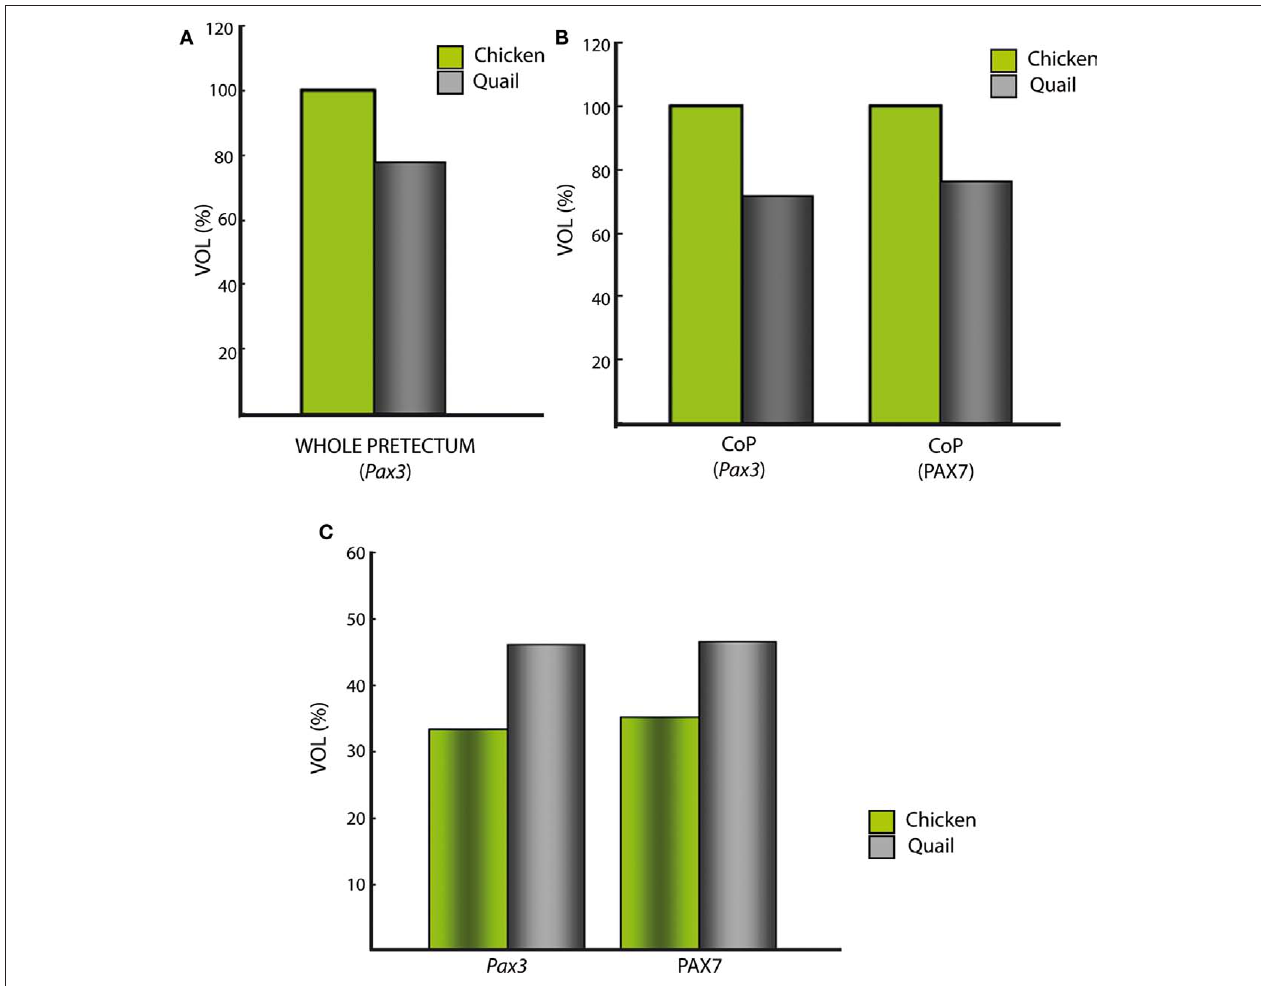
of the genes Pax3 and PAX7. The CoP volume of the chicken was standardized as 100%. Both calculations using Pax3 or PAX7 suggest a similar smaller size of CoP in the quail. (C) The color-coded bars represent the estimated proportion of the intermediate CoP stratum of each species relative to the respective total volume of CoP, separately extrapolated from the expression of the genes Pax3 and PAX7 (similar proportion in